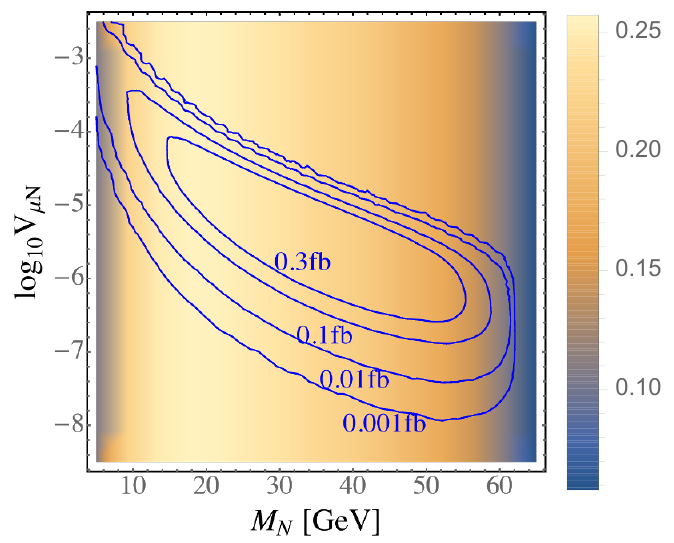
Figure 6 . E(cid:11)ective LHC displaced vertex cross section (cid:27) ( pp function of the RH neutrino mass M N and the neutrino mixing. The background shading represents the kinematic e(cid:14)ciency (cid:15) kin as